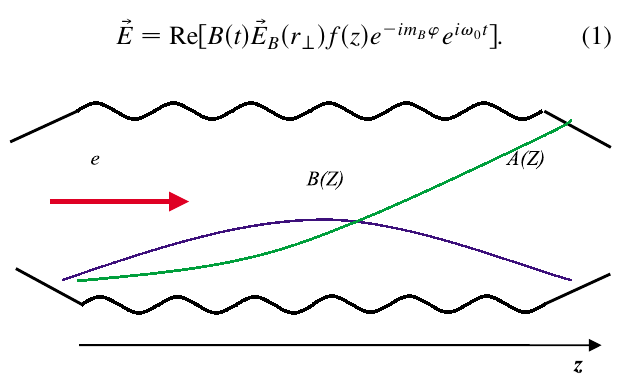
FIG. 1. (Color) Scheme of Bragg FEM based on the coupling of propagating (green line) and cutoff (blue line) modes on the cylindrical waveguide with sidewalls corrugations. Because of a small variation of the waveguide mean radius the cutoff mode is trapped inside the